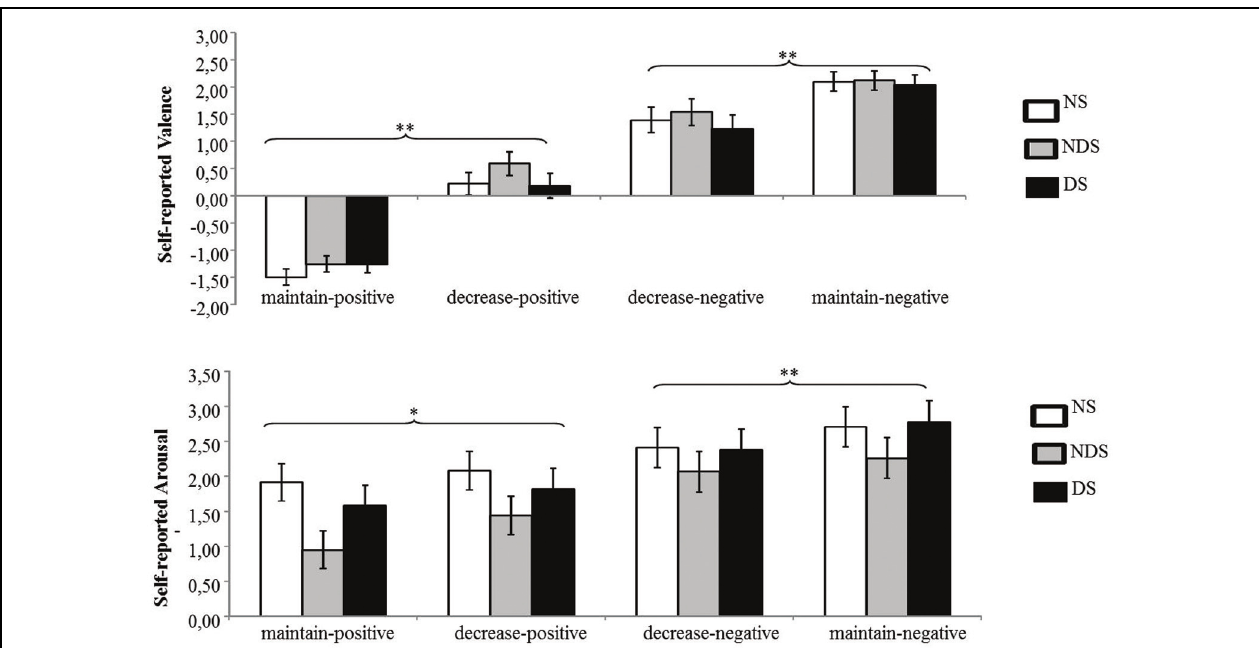
FIGURE 1 | Mean changes in self-reported valence (top) and arousal (bottom) as a function of reappraisal among non-smokers (NS), non-deprived smokers (NDS), and deprived smokers (DS). Depicted are difference scores (specific emotion condition minus baseline condition; see Materials and Methods). The more positive difference scores represent more negative (top) and more arousing (bottom) self-reported emotion under specific emotion condition comparing to baseline condition. Error bars represent standard error of the mean (SEM). ∗ p < 0.05, ∗∗ p < 0.01.